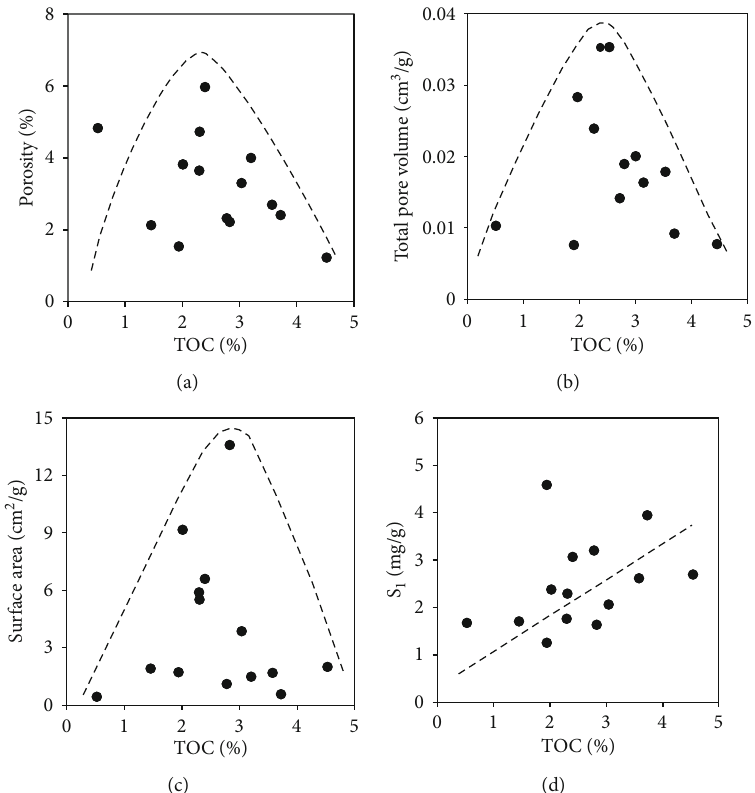
Figure 11: Cross-plots of TOC versus porosity (a), total pore volume from N